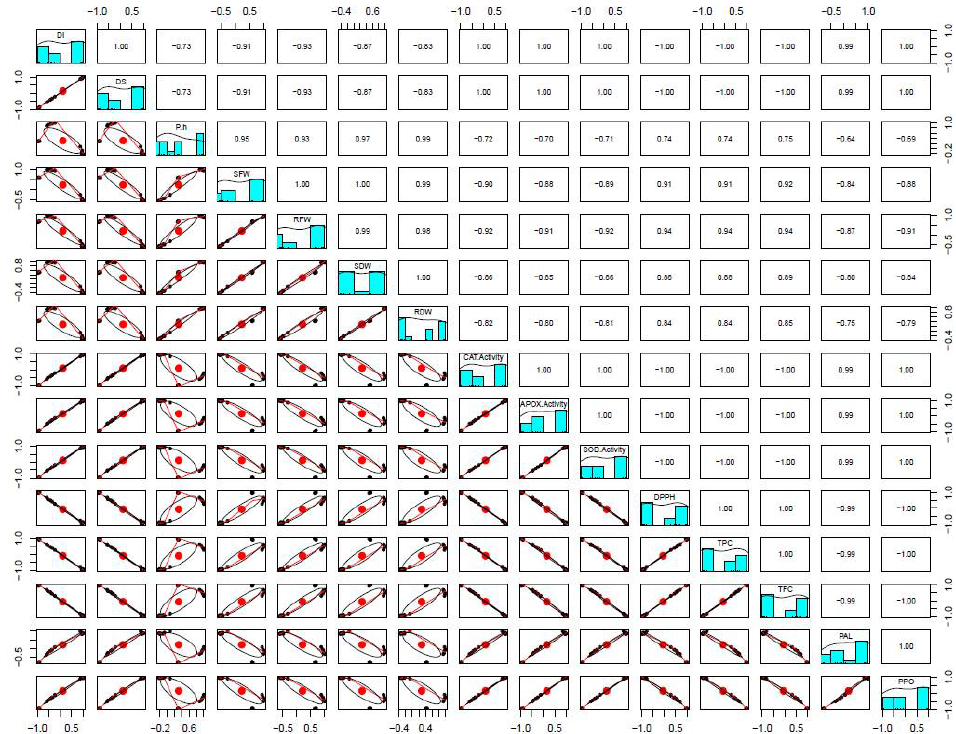
Figure 5. Fold expression in the accumulation of the defense-related genes ( A ) defensin and ( B ) chitinase in Vicia faba L. samples, at different treatments relative to the control, and at different periods. Values are the means (±SD) of three repeated experiments. Different alphabetic superscripts in the same column are significantly different ( p < 0.05) based on Tukey’s multiple comparison test.